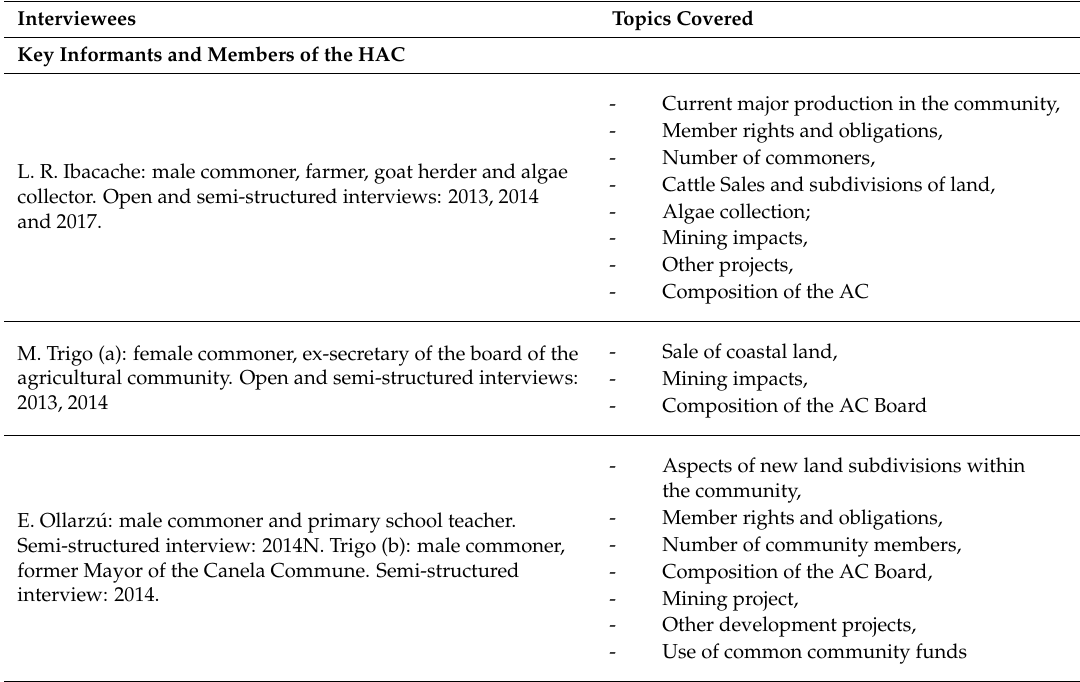
Table 2. Sampling: actors interviewed and topics